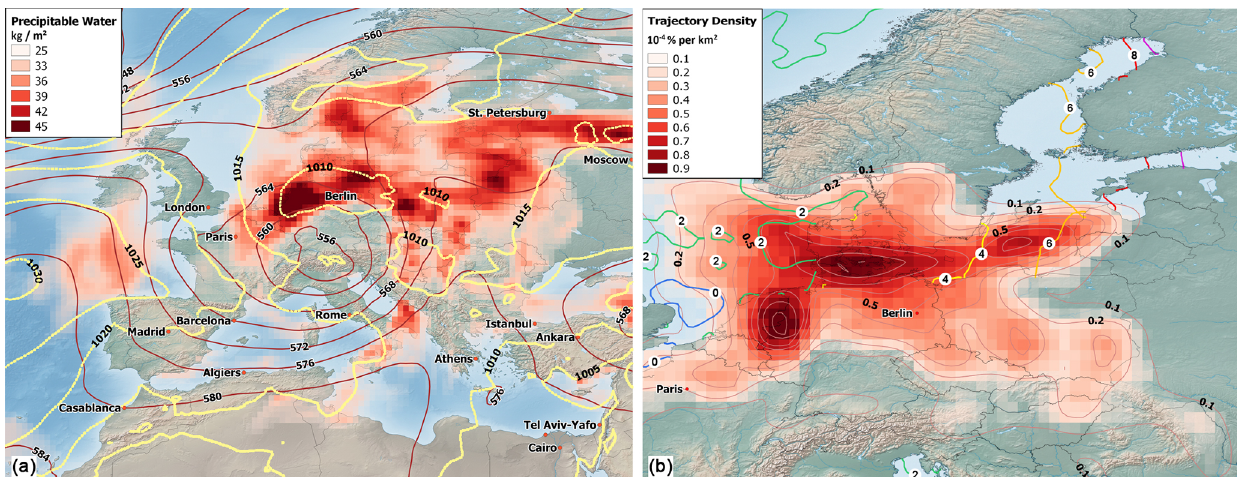
Figure 2. (a) 500hPa geopotential (solid contours in gpdm), mean sea level pressure (dashed contours in hPa), and total precipitable water (shading in kgm − 2 ) on 14 July 2021 12:00UTC (ERA5). (b) Density of air parcels (based on trajectories analysis) in the PBL (planetary boundary layer) over the entire 10d period (shading and red contours every 0.1% per area of 10 4 km 2 starting at 0.1% per area of 10 4 km 2 ; ERA5); the outermost contour encloses 67% of all air parcels. SST anomaly relative to the climatology (ERA5, 1971–2000; averaged from 8 to 15 July 2021; colored contours in K). Both backgrounds made with © Natural Earth.